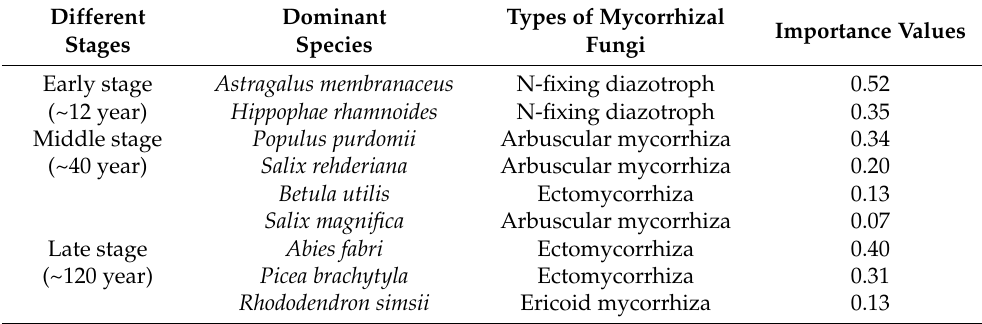
Table 2. Identities, types of mycorrhizal fungi and importance values of dominant species at different successional